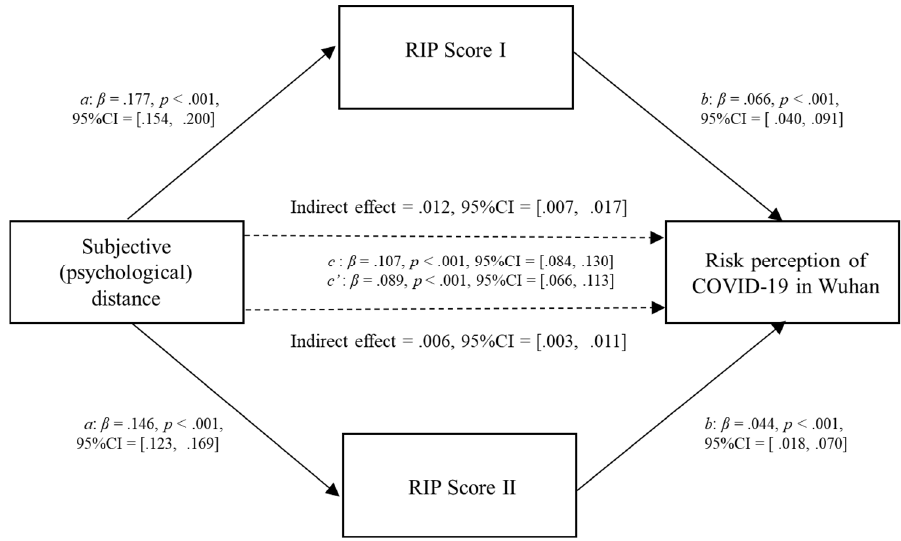
Figure 6. Parallel mediation model showing the effects of subjective (psychological) distance and risk information proportion on the risk perception of COVID-19 in Wuhan; N = 7284. Table 6. Parallel mediation model showing the effects of subjective (psychological) distance and risk information proportion on the risk perception of COVID-19 in Wuhan ( N = 7284, adult data with no missing values).